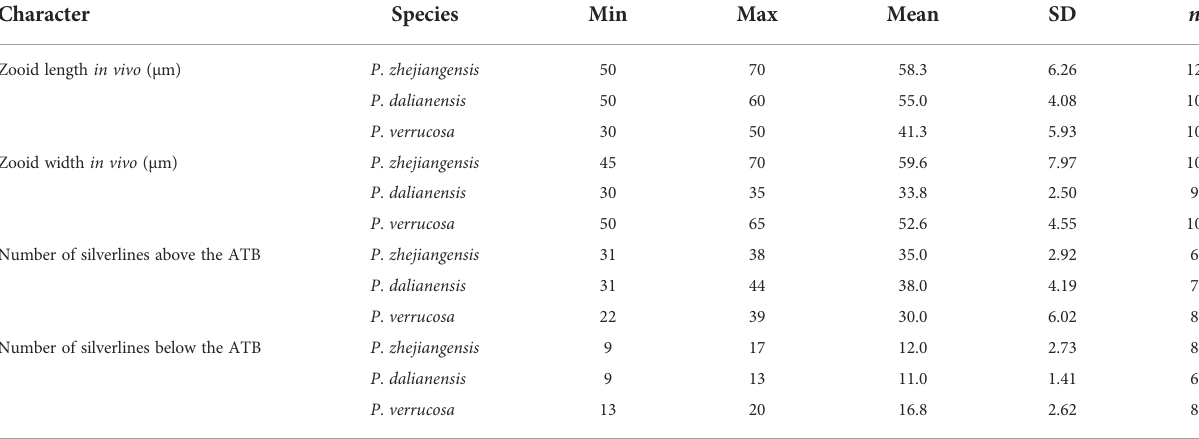
TABLE 1 Morphometric data of Pseudovorticella zhejiangensis sp. n., Pseudovorticella dalianensis sp. n., and Pseudovorticella verrucosa .